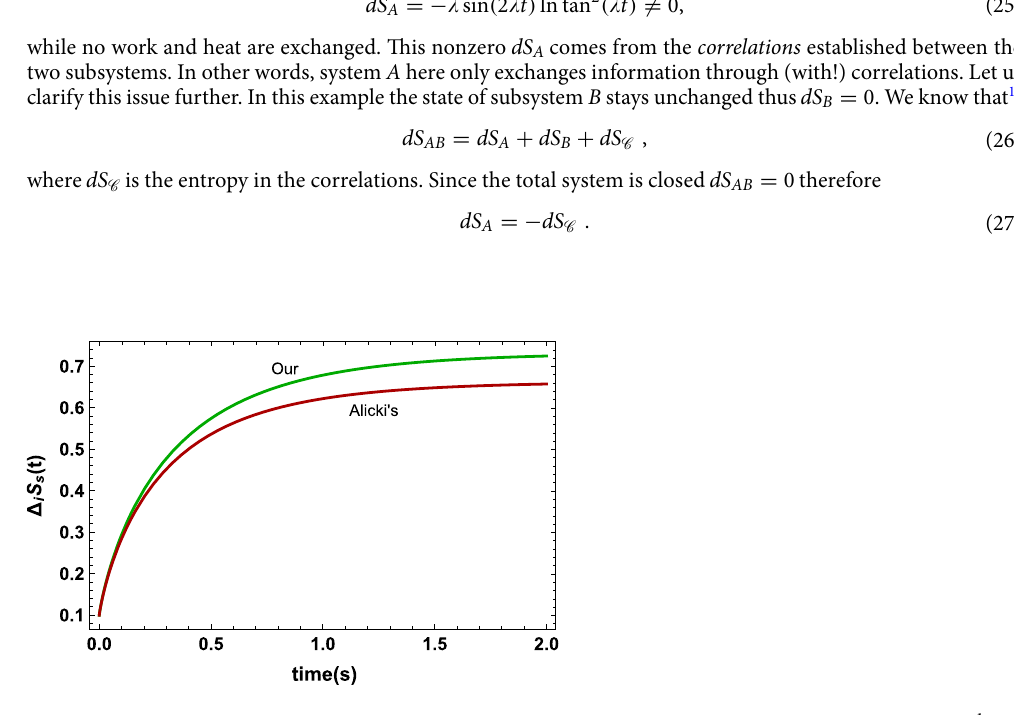
Figure 5. The entropy production of the system � i S s ( t ) versus time t for a two-level system with ω 0 = 2 s − 1 in contact with a thermal bath with temperature T = 10 K and decay rate γ( t ) = 0.2 s − 1 . It is seen that